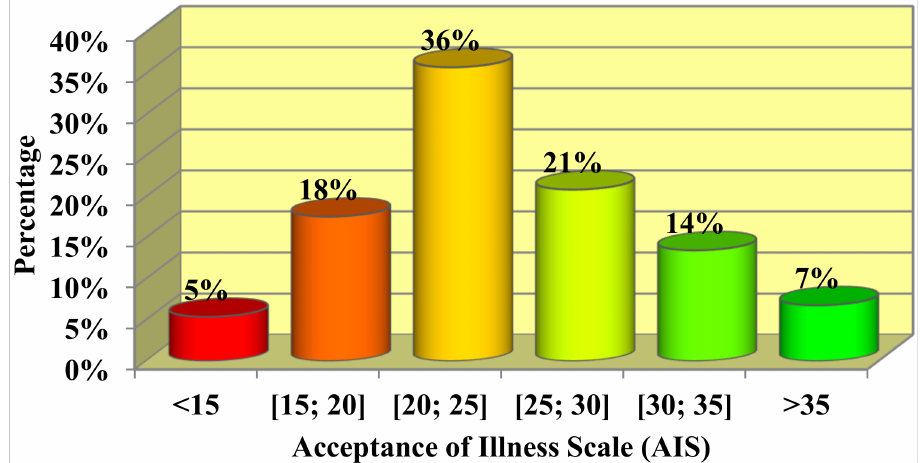
Figure 1. Percentage of patients with five-point ranges of values on the acceptance of illness scale